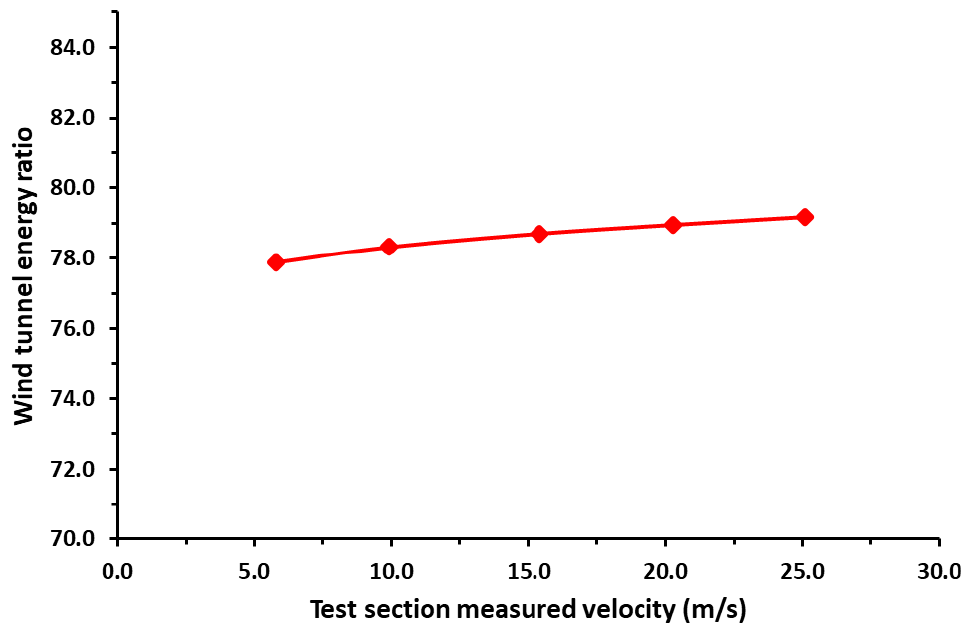
Figure 13. Wind tunnel energy ratio versus test section measured velocity.